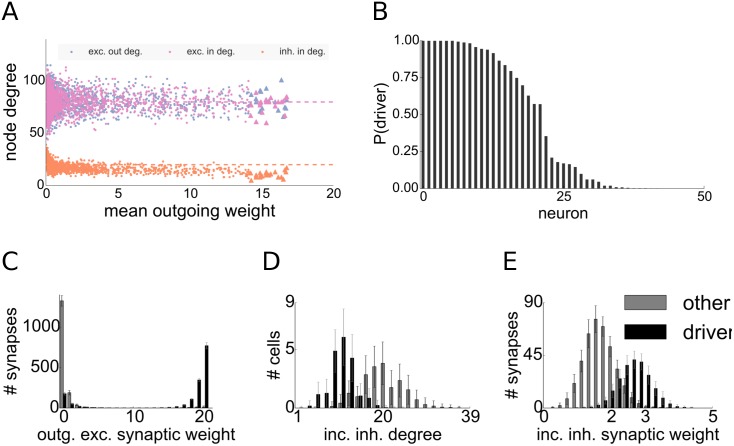
Statistics and connectivity of driver cells.
A: Scatter plot of the mean outgoing synaptic weight after synaptic plasticity versus node degrees of excitatory cells for one network realization. Dashed lines denote corresponding means. B: Probabilities of excitatory cells to belong to the driver group, computed by sampling N = 1000 network realizations with fixed topology but different input. Descendingly sorted by probability. C-E: Statistics of connectivity of driver cells and a group of 20 randomly sampled non-driver cells. C: Distributions of the strengths of outgoing synapses, D: Inhibitory in-degree, E: Efficacies of incoming inhibitory synapses. Bars denote average over 1000 trials, whiskers indicate standard deviation.